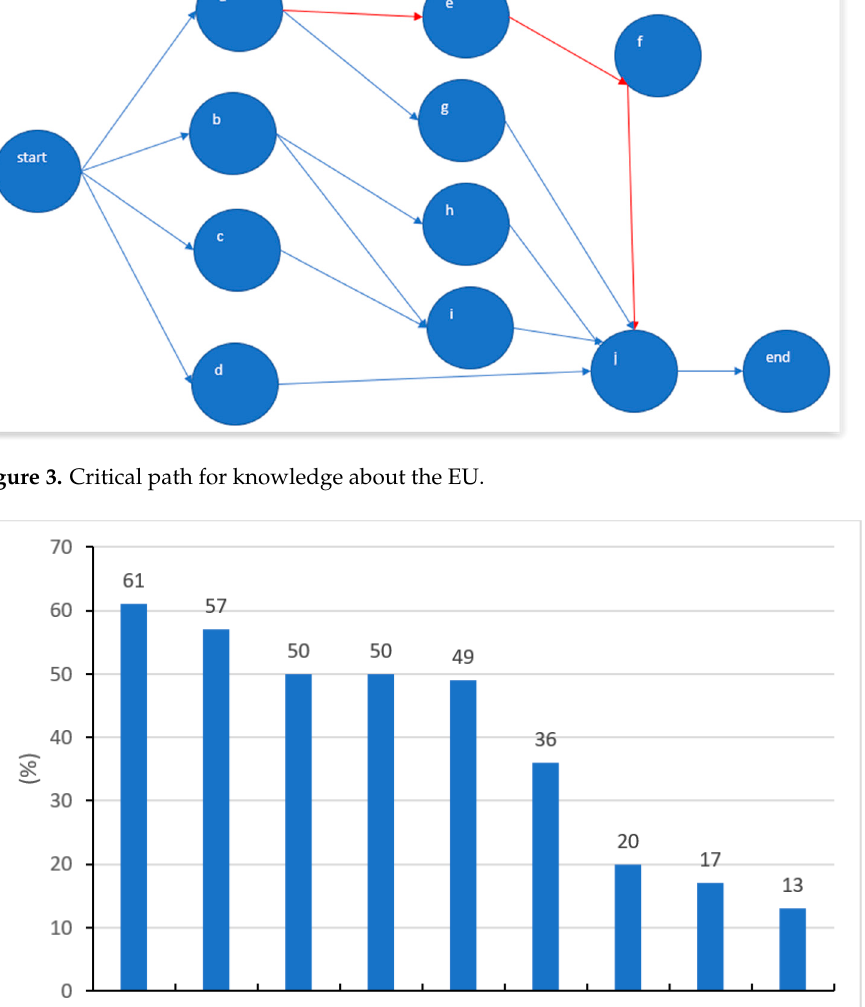
Figure 3. Critical path for knowledge about the EU.